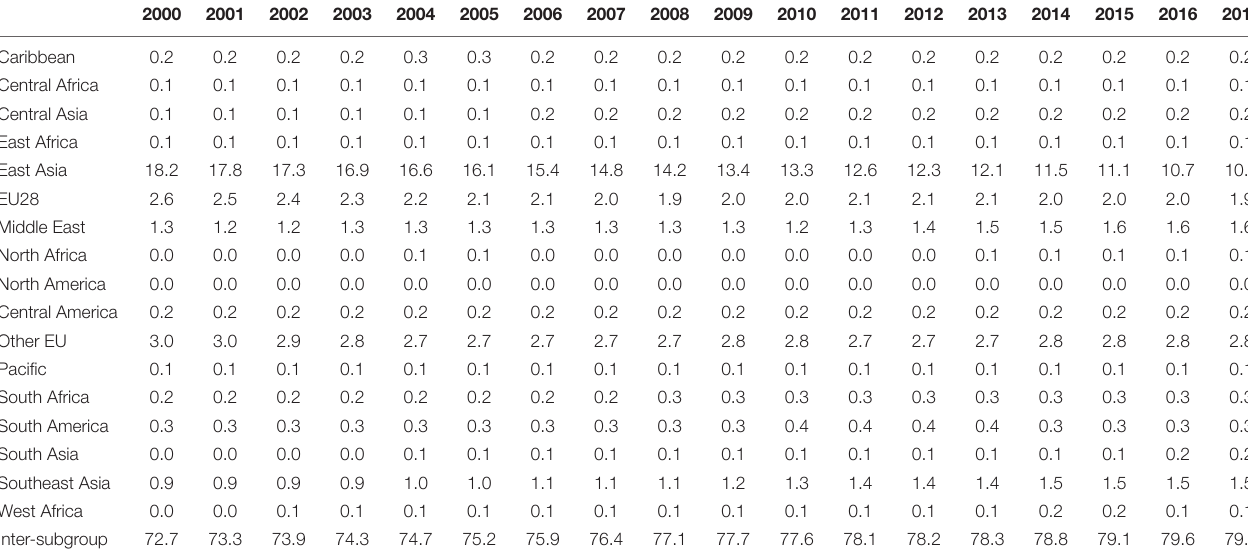
TABLE 6 | Decomposition of inequality (Theil-T) for 17 regional subgroups,